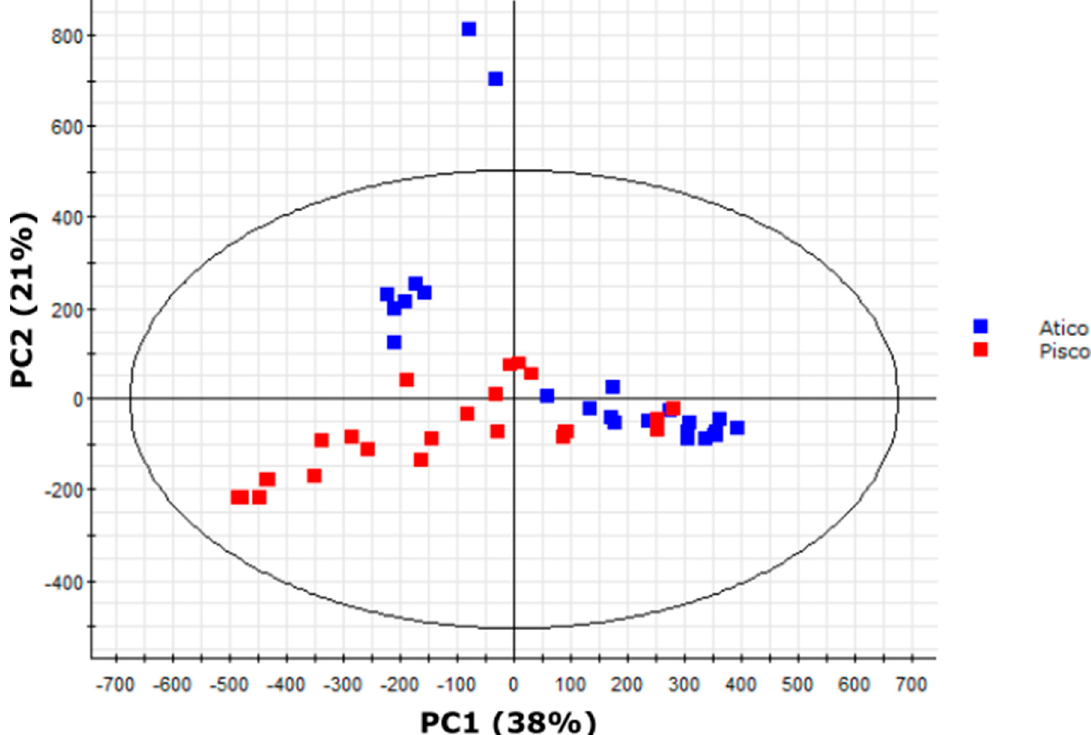
Figure 6. PCA scores plot of samples from eight S. pennellii accessions from the southern portion of the range of the species in Peru separated by abundances of 54 metabolite features identified in trichome extracts by UHPLC–HR-MS. Samples from the Atico region are indicated in blue, while samples from the Pisco region are indicated in red (see Figure 2 for details on regions). Separation is observed between Atico and Pisco samples. However, Atico region samples exhibit bimodal clustering. PC1 accounted for 38% of variance and described most of the variation between accession LA2963 samples and other Atico region accessions, while PC2 accounted for 21% of variance and described primarily variation within the main Atico cluster.